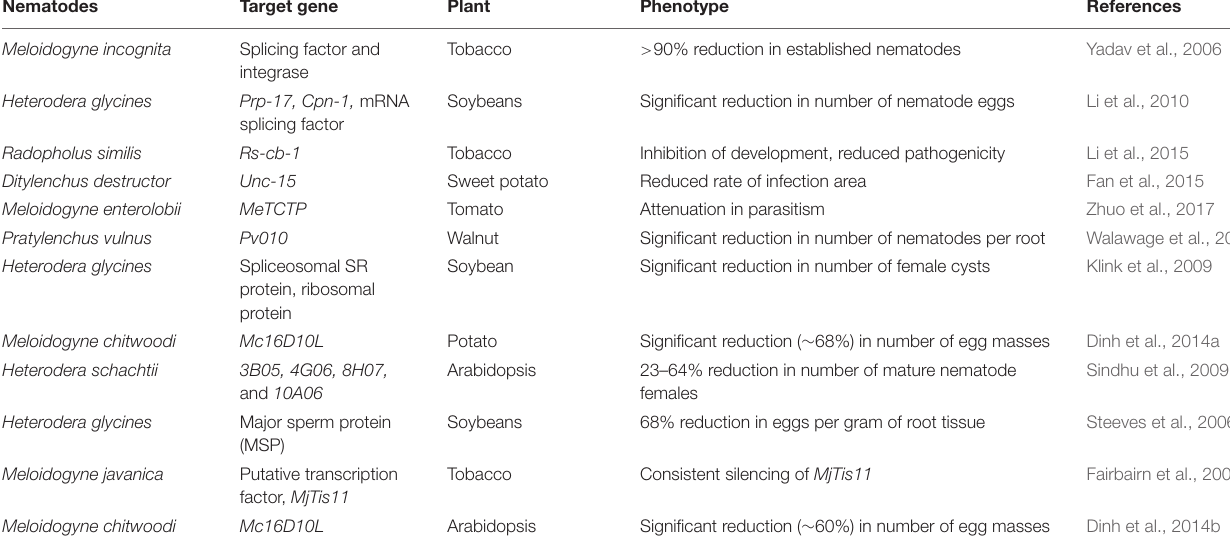
TABLE 3 | RNAi-targeted editing in plants against